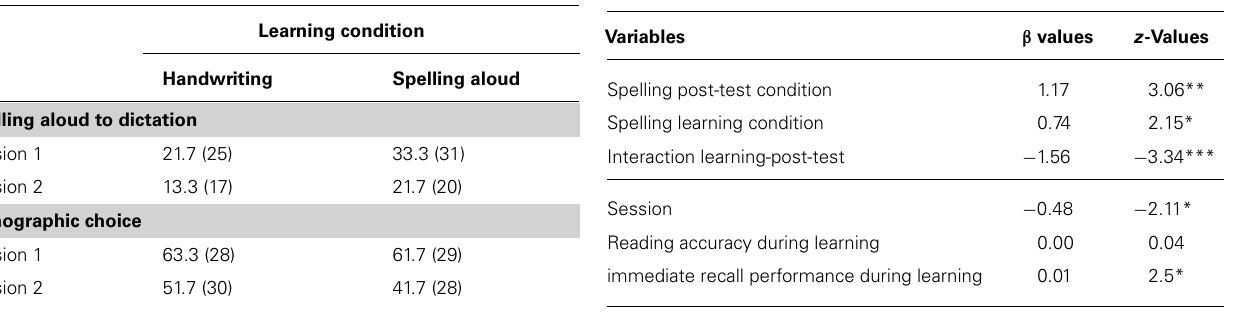
Table 5 | Experiment 2. Mean accuracy (in percentages) and standard deviations for spelling aloud to dictation task and for orthographic choice task, according to conditions and sessions.